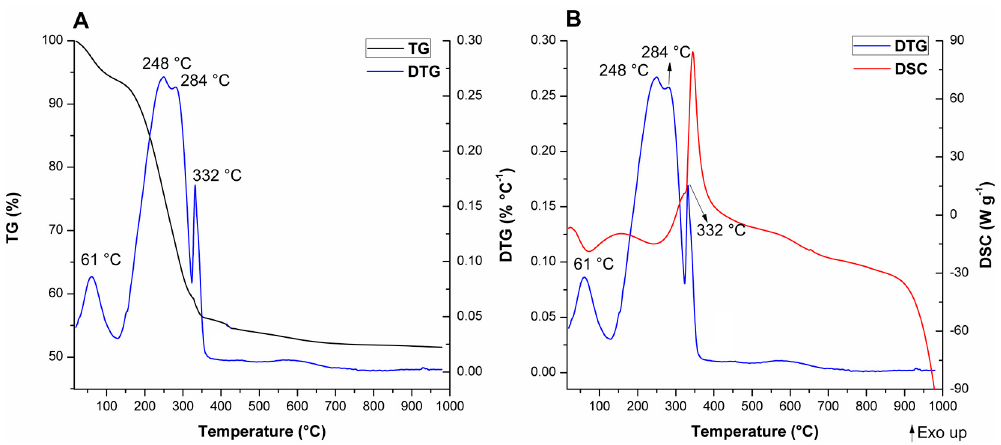
Figure 11. Thermal analysis obtained under synthetic air for A-Si-MCM-41: TG and DTG curves ( A ); DTG and DSC curves ( B ). The temperatures indicated refers to the DTG maximums of observable peaks.